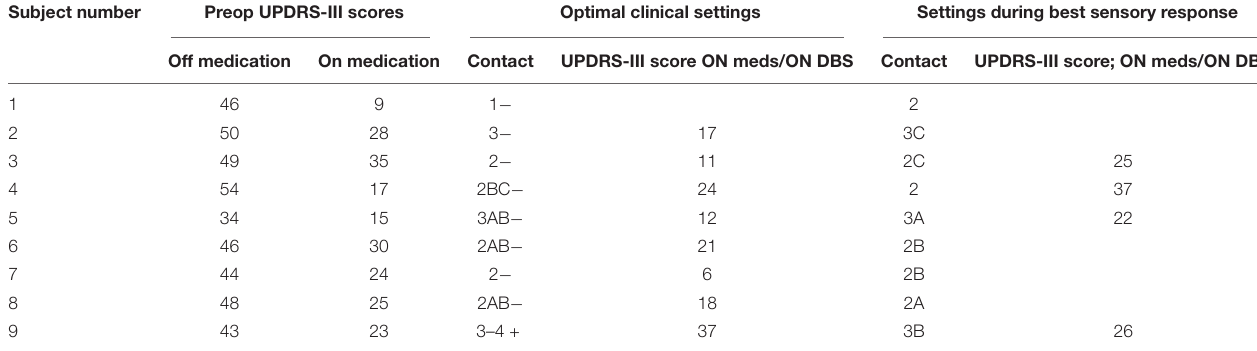
TABLE 5 | Results of UPDRS-III motor